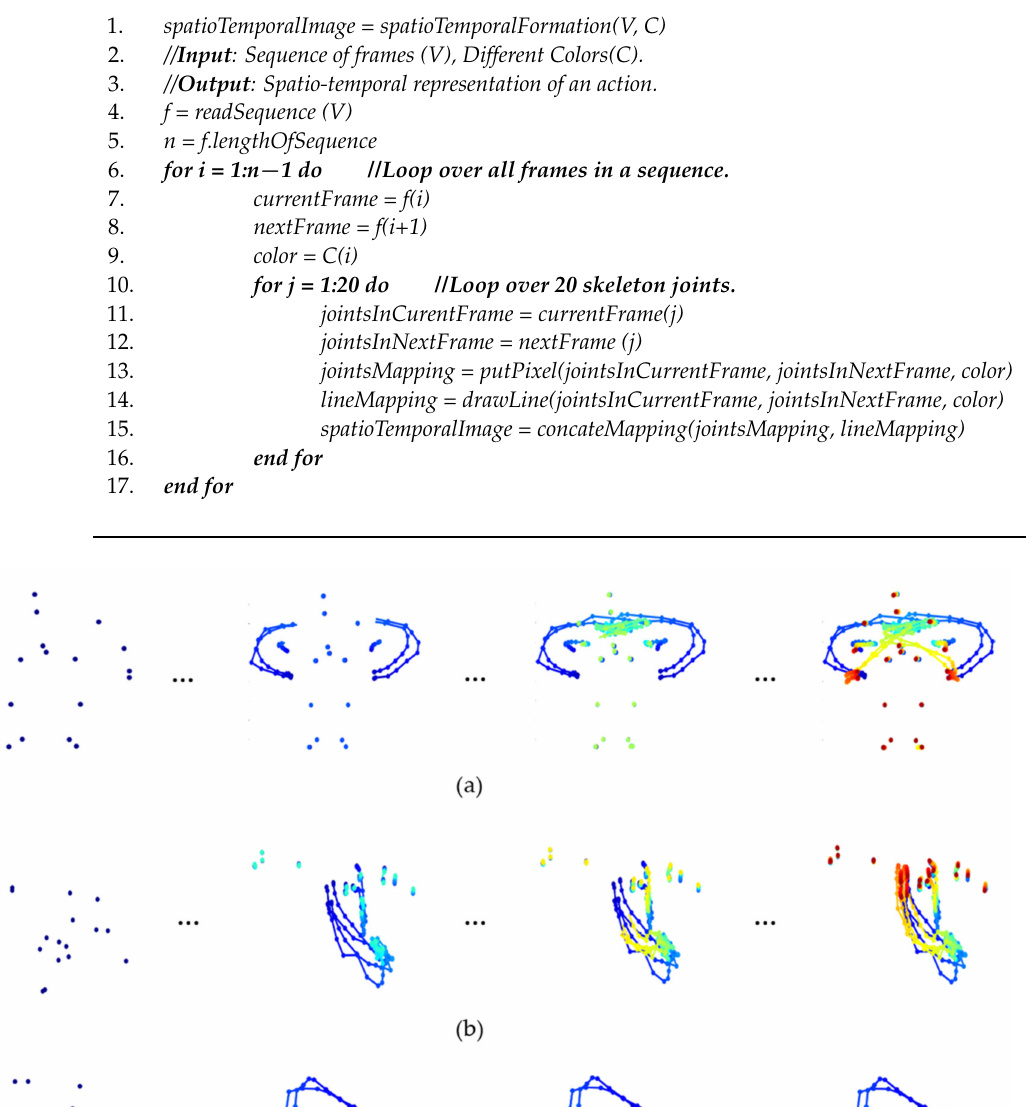
Algorithm 1. Steps in spatio-temporal image representation from 3D human skeleton joints